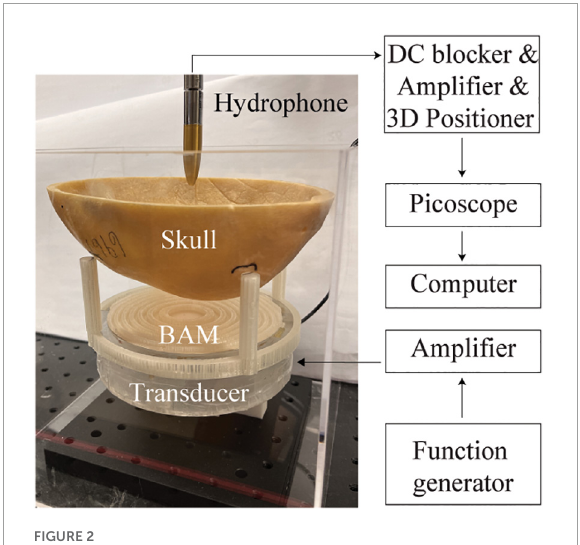
FIGURE2 Experimental setup for validating the designed BAM coupled with a plat ultrasound